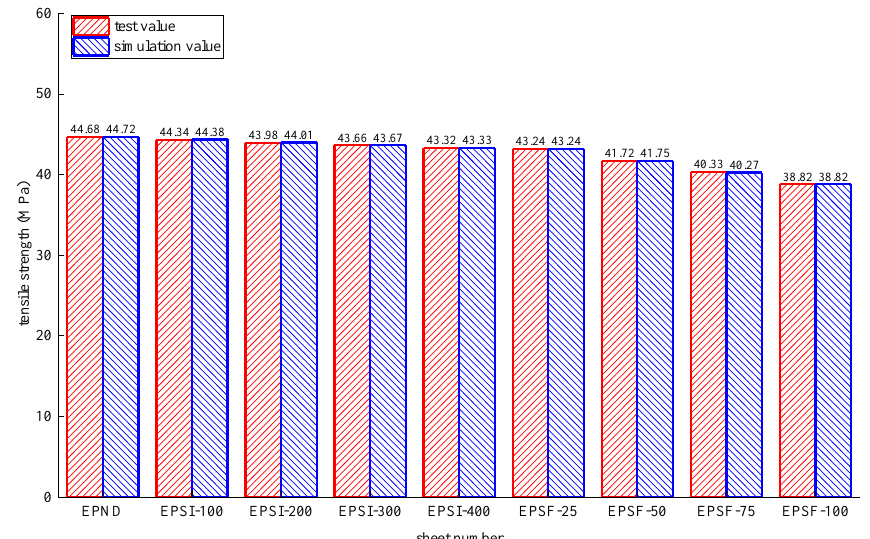
Figure 34. Test values and simulated values of tensile strength of epoxy resin.